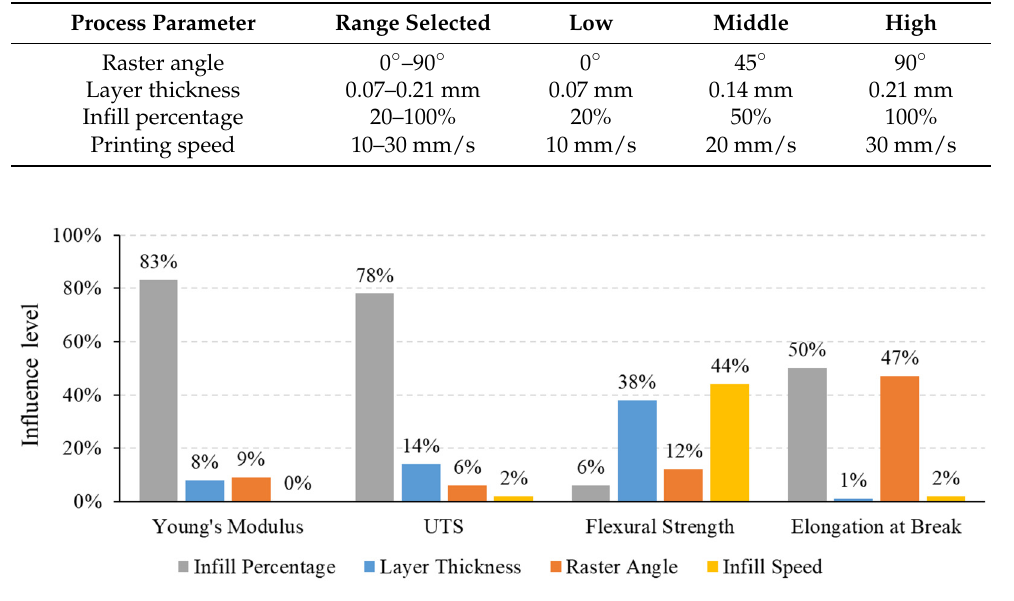
Figure 15. Process parameter’s relative influence on PEEK mechanical properties. Table 7. Table ranking parameters according to influence on PEEK mechanical properties as deter ‐ mined by ANOVA.